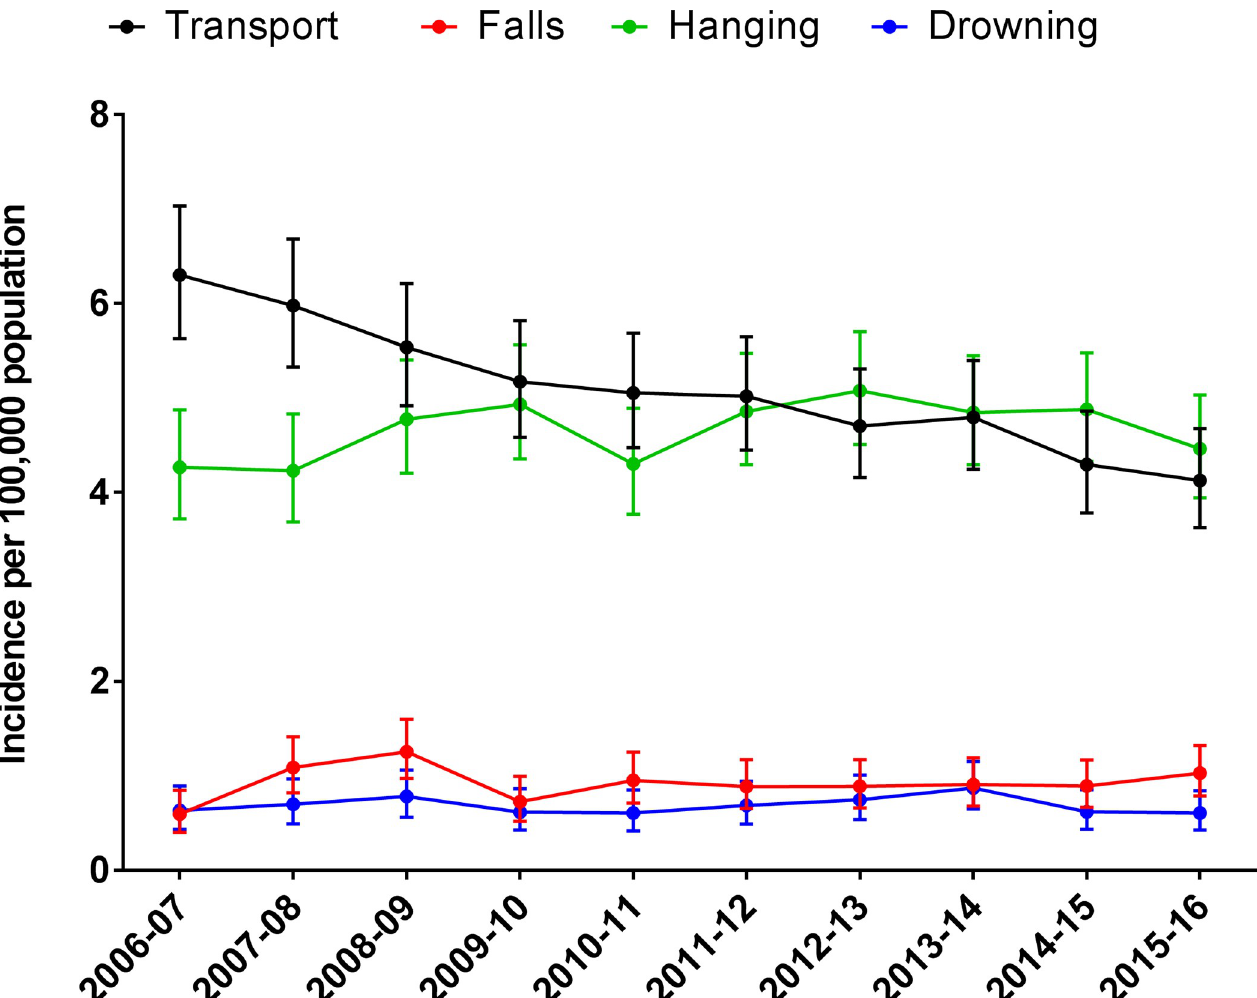
Fig 4. The incidence of out-of-hospital trauma deaths by mechanism of